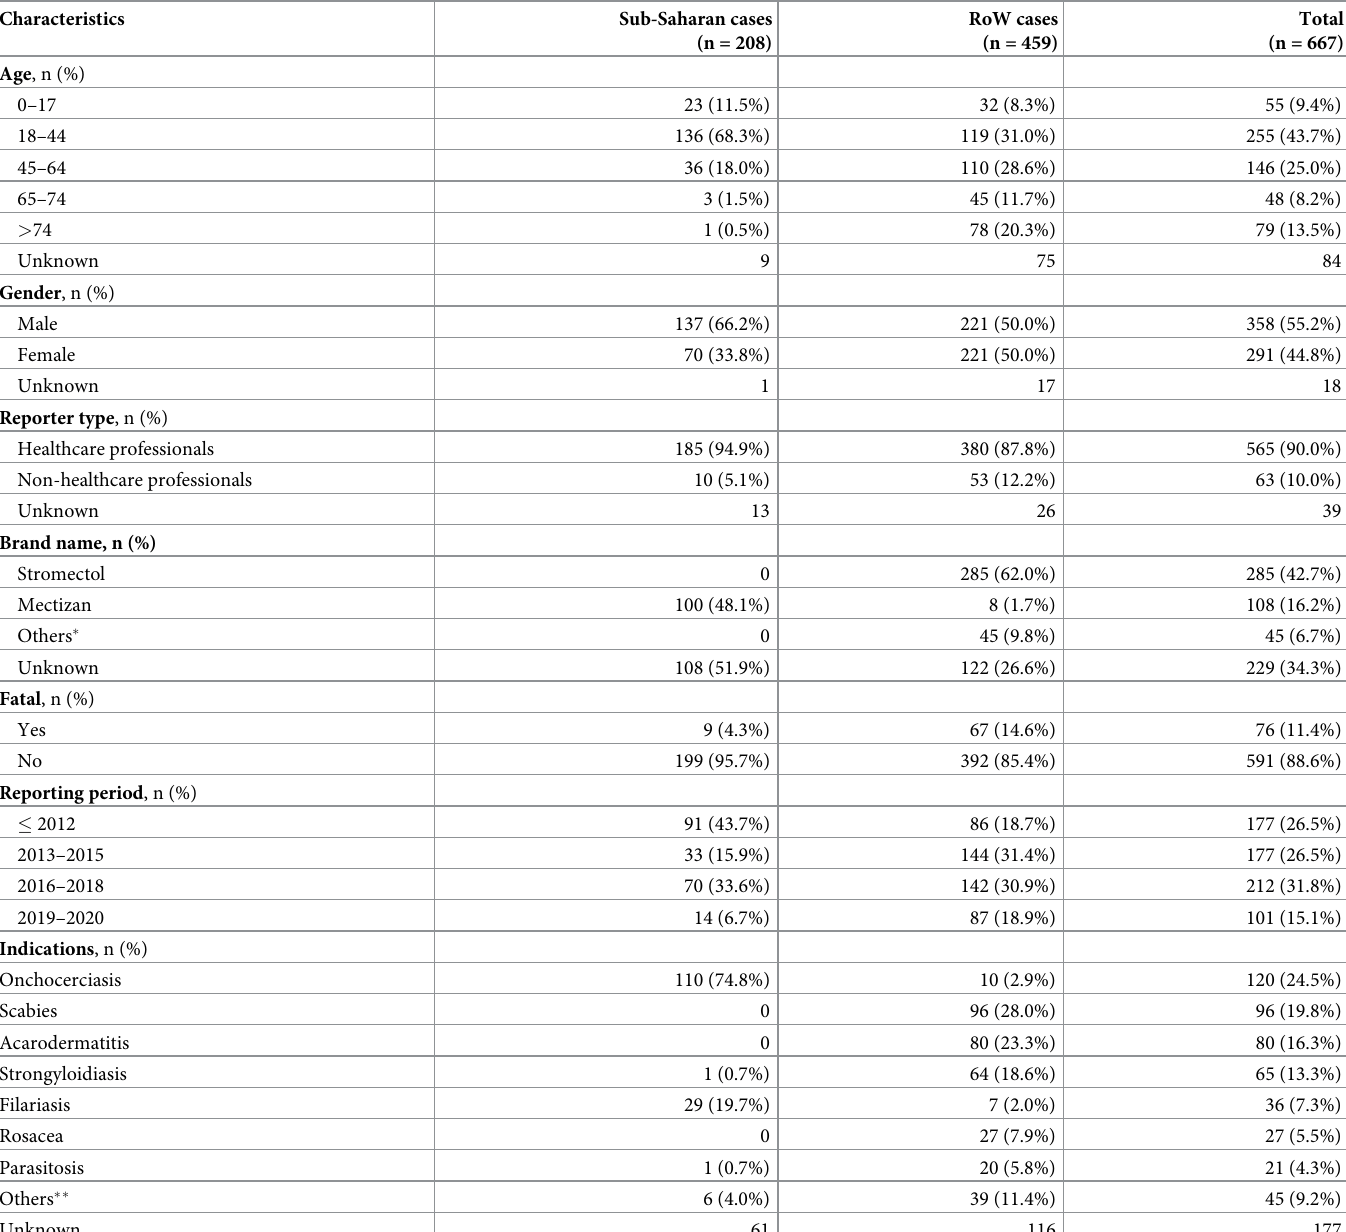
Table 2. Characteristics of sADRs exposed to ivermectin reported in VigiBase according to geographical origin.